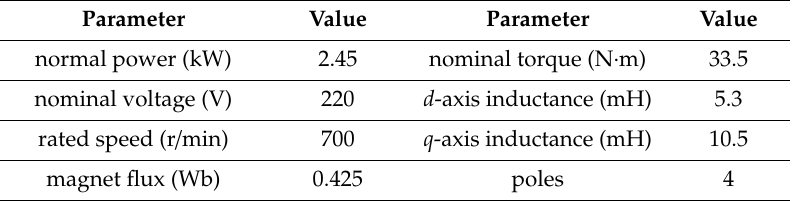
Table 1. Parameters of permanent magnet synchronous motor